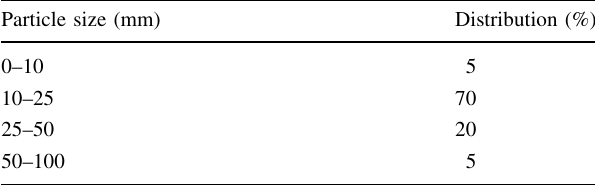
Table 2 Coal particle size distribution